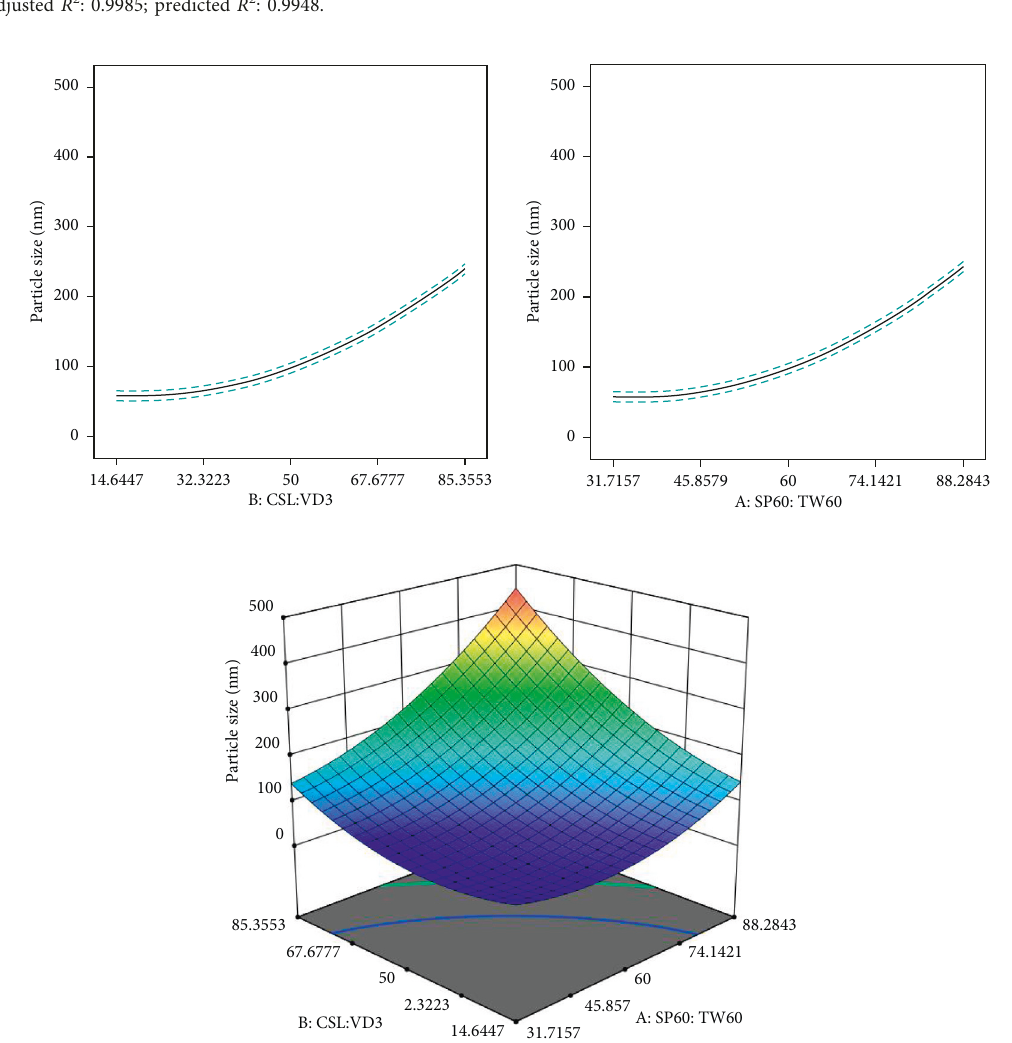
Figure 1: Effects of Span 60: Tween 60 and cholesterol: vitamin D3 ratio on particle size of